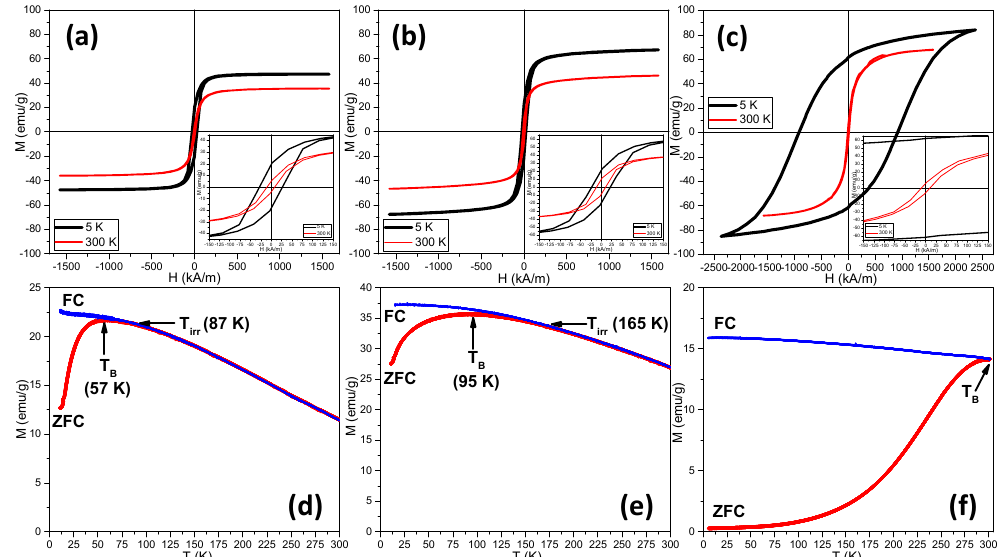
Figure 2. Magnetic hysteresis loops measured at 5 K and 300 K and zero-field cooling and field cooling magnetization curves for ( a , d ) NiFe 2 O 4 , ( b , e ) MnFe 2 O 4 , and ( c , f ) CoFe 2 O 4 . Insets represent low-field regime hysteresis loops. Table 2. Magnetic hysteresis parameters of ferrite MNPs.